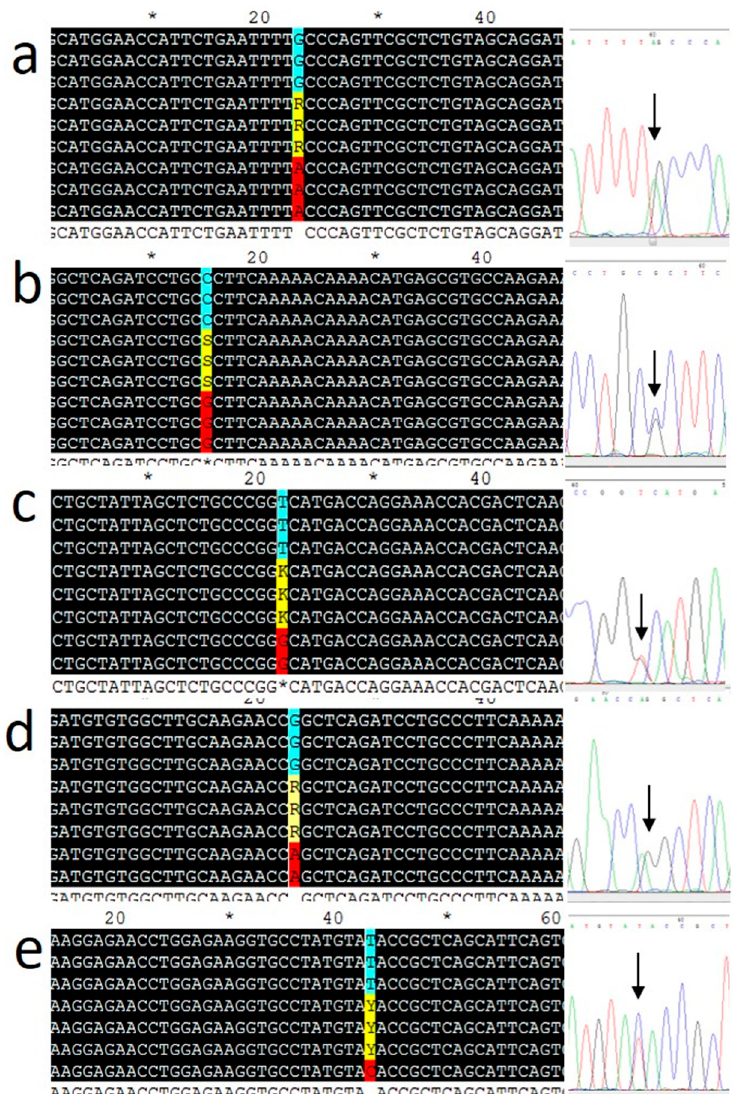
Figure 1. Verification of genotyping results by Sanger sequencing. ( a ) rs182052 (G / A); ( b ) rs266729 (C / G); ( c ) rs2241766 (T / G); ( d ) rs17300539 (G / A); ( e ) rs17366743 (T / C). Arrows on the sequence chromatograms indicate heterozygotes.